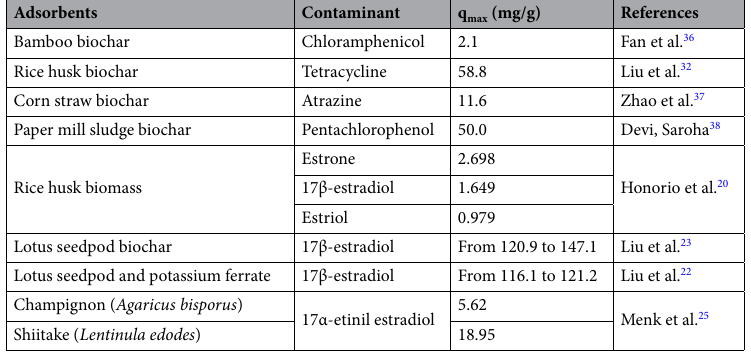
Table 4. Studies with different adsorbents for removal organic